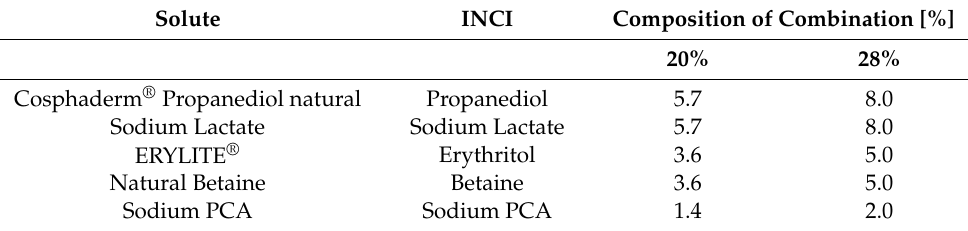
Table 1. Composition of the a w -reducing solute combinations.